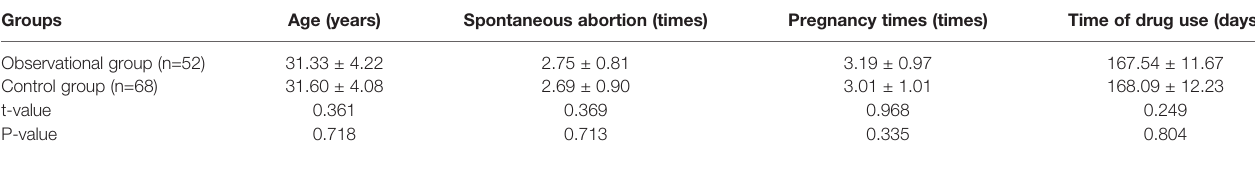
TABLE 1 | Comparison of general data between the two groups of patients (mean ±standard deviation). Groups Observational group (n=52)